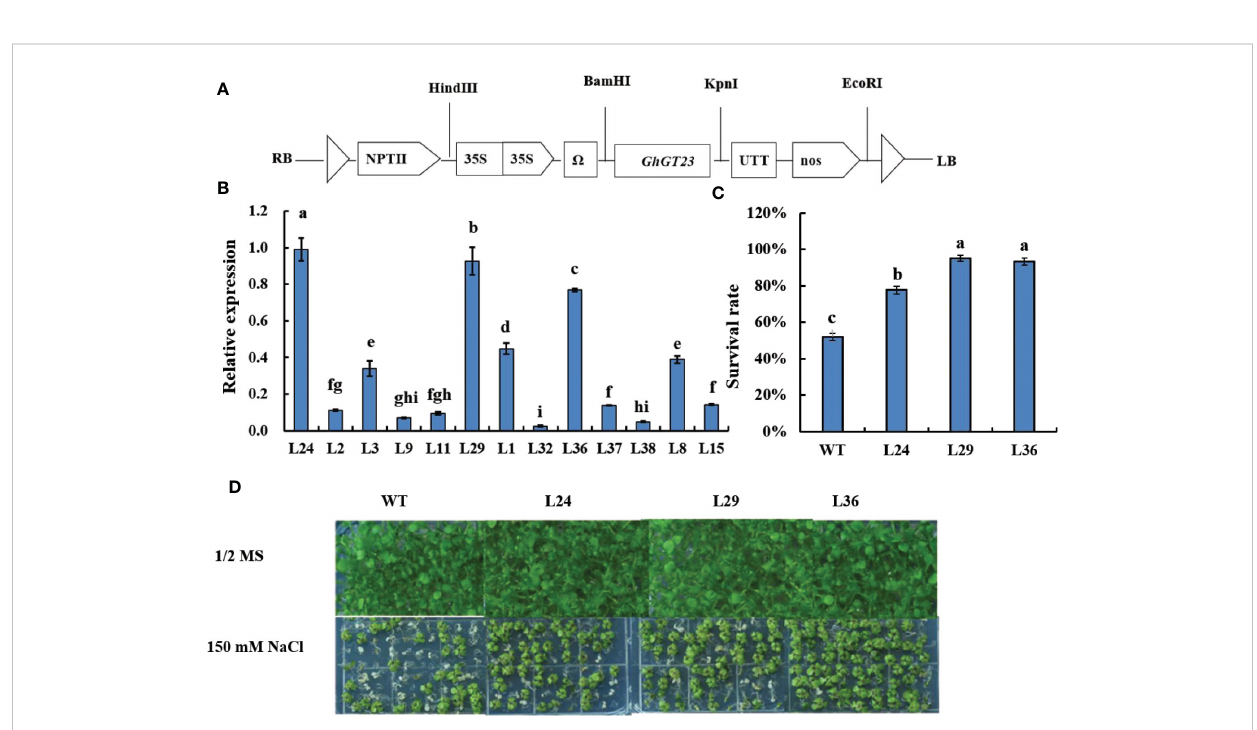
FIGURE 5 The survival rate of Arabidopsis GhGT23 -overexpressing lines exposed to 150 mM NaCl on 1/2 MS agar plates. (A) Diagram of the GhGT23 - overexpression cassette. (B) Quanti fi cation of GhGT23 transgene expression in Arabidopsis transgenic lines. (C) Quanti fi cation of the seedling survival rate in WT and transgenic lines after 16 days of growth on 1/2 MS agar supplemented with 150 mM NaCl. Error bars indicate standard deviation and different letters indicate signi fi cant differences (p < 0.05), which were determined using ANOVA, followed by Duncan ’ s multiple comparison test. (D) Images of WT and transgenic lines taken after 16 days of growth on 1/2 MS agar with and without 150 mM